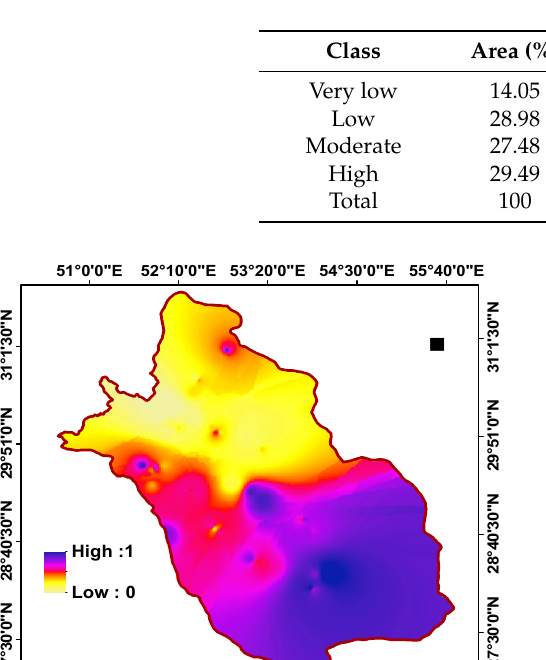
Table 5. The area of each class for KSP.